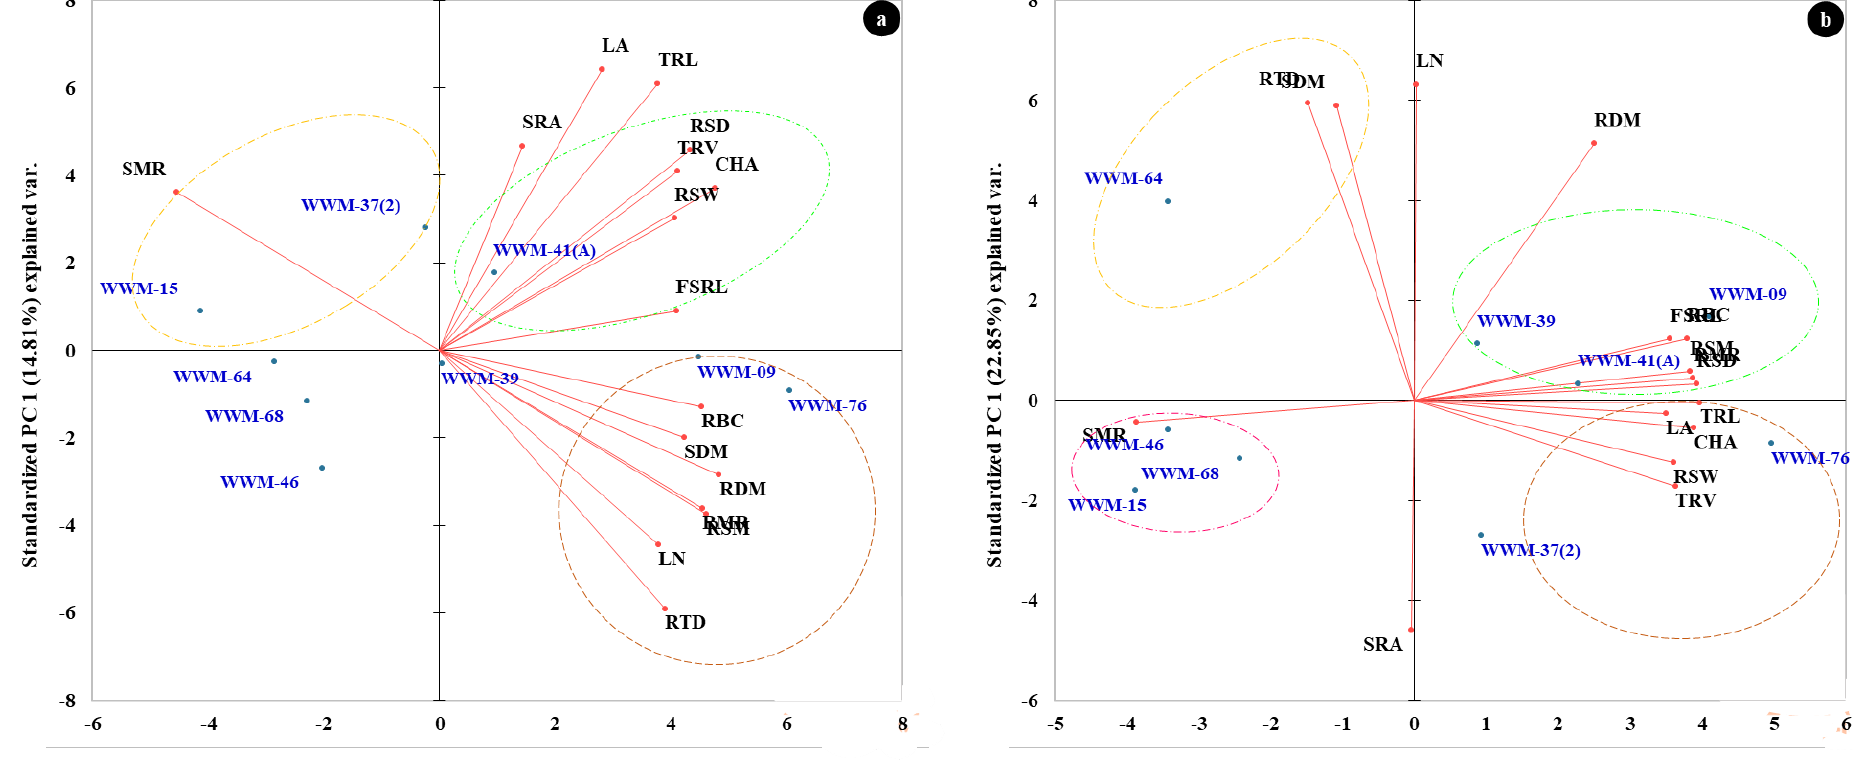
Figure 5. Principal component (PC) biplot of PC 1 vs. PC 2 demonstrating the relationship between root and leaf traits of nine citron watermelon accessions evaluated in rhizotrons under ( a ) non-stress and ( b ) water stress conditions.